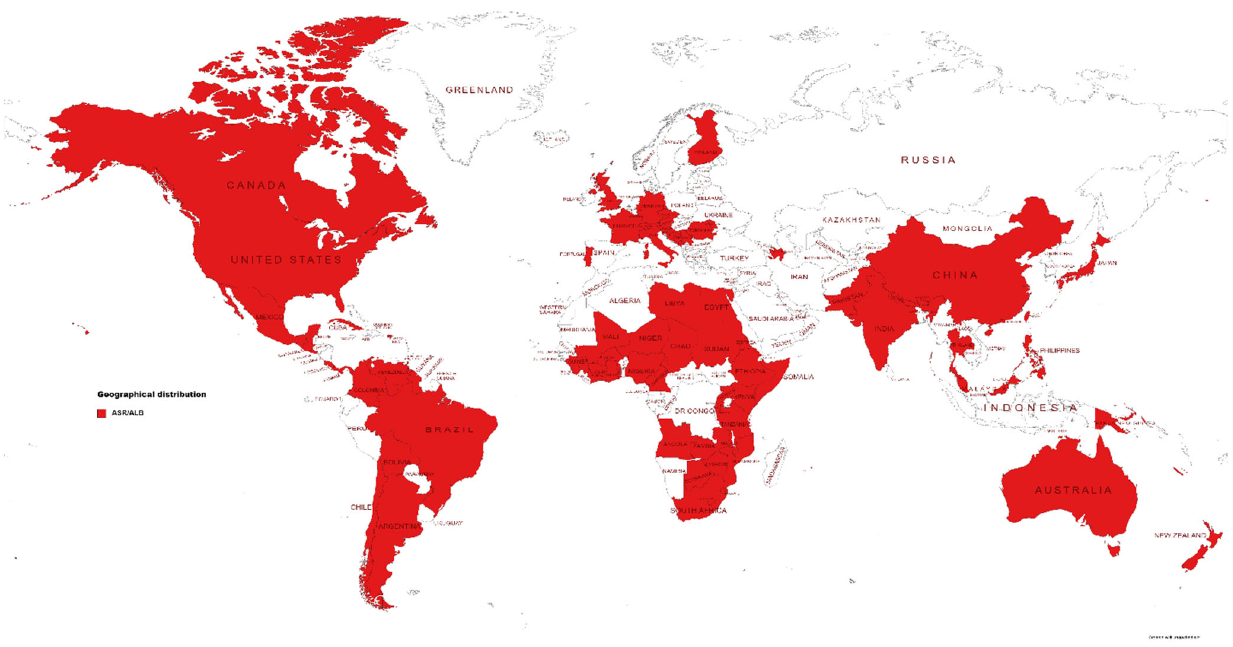
Figure 2. Global distribution of anthracnose leaf blight (ALB) and anthracnose stalk rot (ASR). Despite economic significance, molecular genetics underlying ASR and ALB lags behind other fungal diseases, such as ear and stalk rot caused by Fusarium spp. Here, we revisit the infection cycle of C. graminicola and discuss the genetic architecture of ALB/ASR resistance and the molecular basis of the C. graminicola virulence on maize.